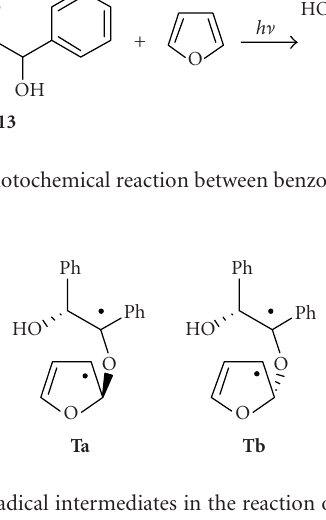
Figure 10: Biradical intermediates in the reaction of benzoin with